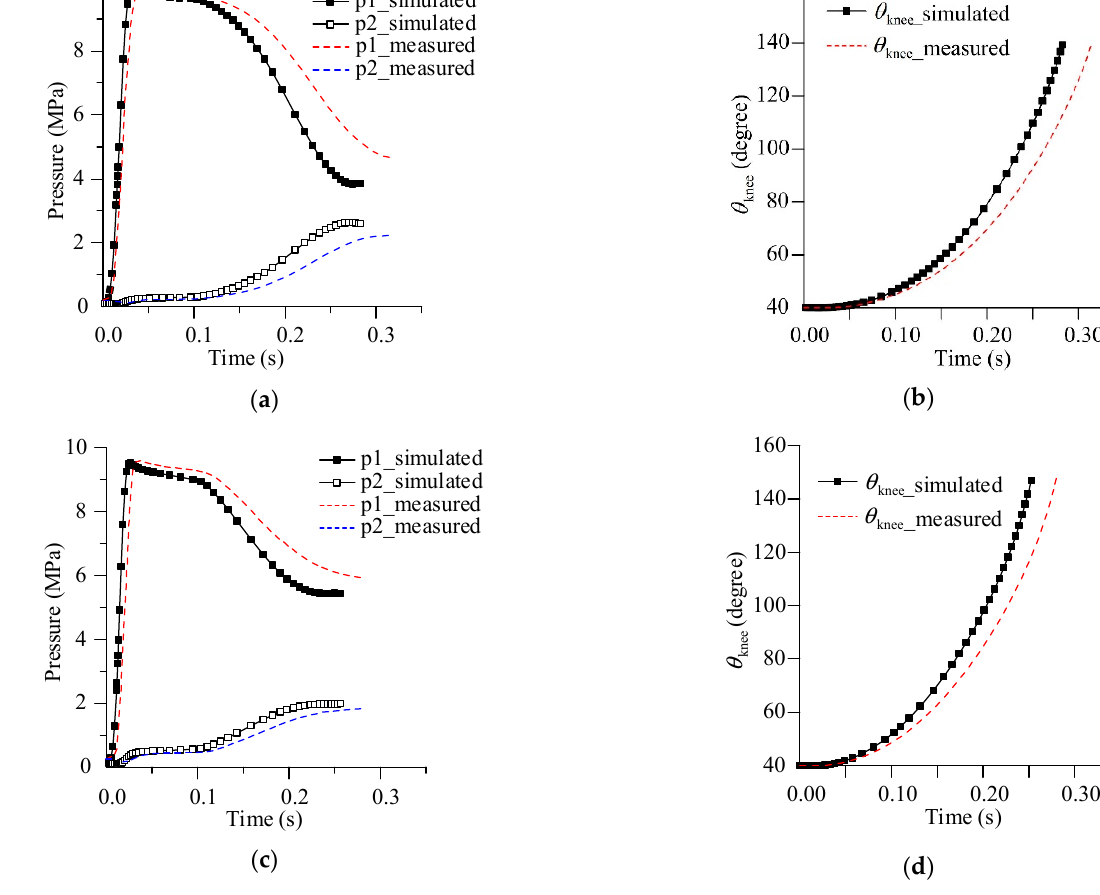
Figure 7. Simulation and experiment results of the cylinder pressures and knee joints under the DAG and FMAG. ( a ) Cylinder pressures of the DAG; ( b ) Knee joint angle of the DAG; ( c ) Cylinder pressures of the FMAG; ( d ) Knee joint angle of the FMAG. Table 4. Hopping results of the kangaroo inspired one-legged robot.